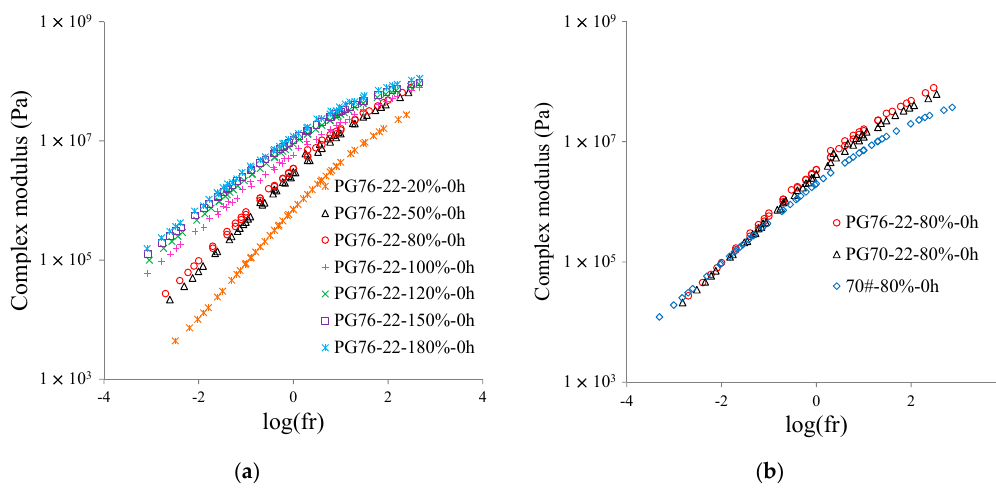
Figure 6. Master-curve of the complex modulus of mastics with different compositions before aging: ( a ) different filler contents; ( b ) different binders.